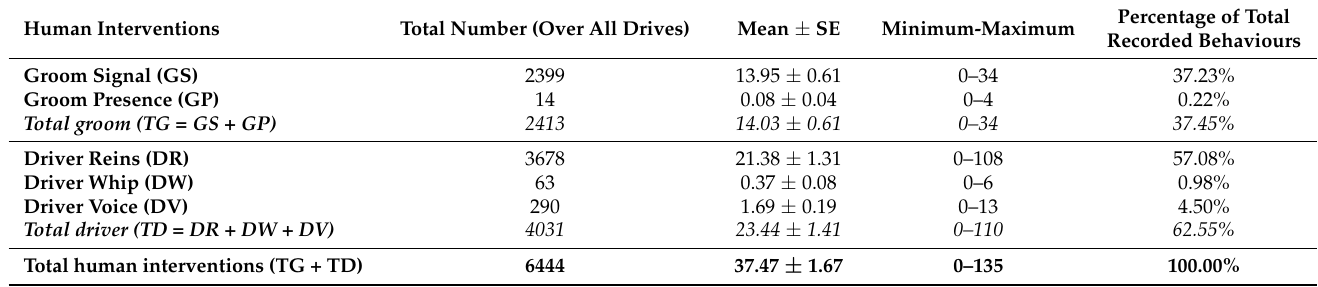
Table 5. Descriptive statistics of the number of observed human interventions to stop stallions driven in pairs from interacting over the course of the study (Total number of occurrences mean ± SE; min-max; percentage of total recorded interventions). The number of occurrences in italics indicates the number of occurrences for the total groom, resp. total driver interventions. The number of occurrences in italics and bold indicates the number of occurrences for the total groom and driver interventions. See Table 2 for the detailed